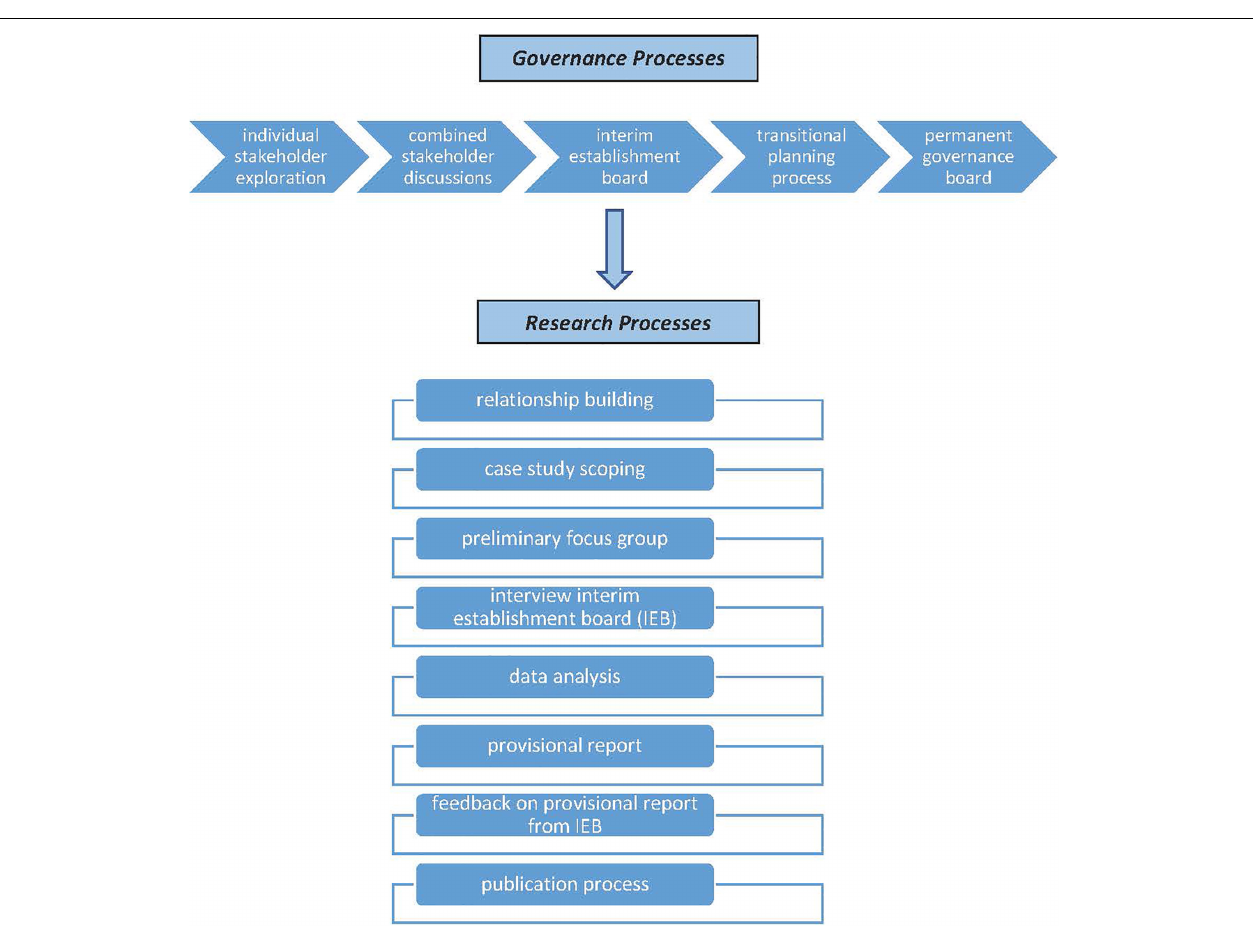
FIGURE 1 | Intersection of grassroots health governance processes and research